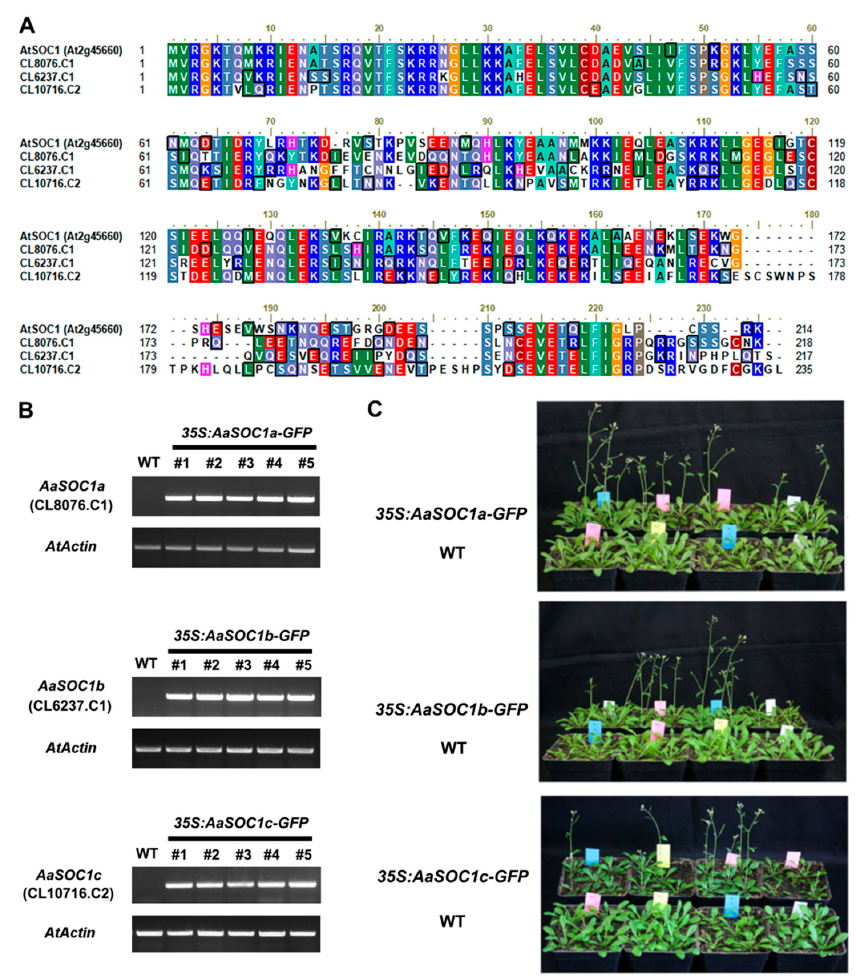
Figure 6. Phenotypic analysis of transgenic Arabidopsis overexpressing three SOC1-type AaMADS genes. ( A ) Amino acid sequence alignment of three SOC1-type AaMADS (CL8076.C1, CL6237.C1, and CL10716.C2) with Arabidopsis AtSOC1 (At2g45660) protein. Semi-quantitative PCR detection ( B ) and flowering time phenotypes ( C ) of transgenic lines overexpressing three SOC1-type AaMADS genes. The AaActin gene was used as an internal control. WT: